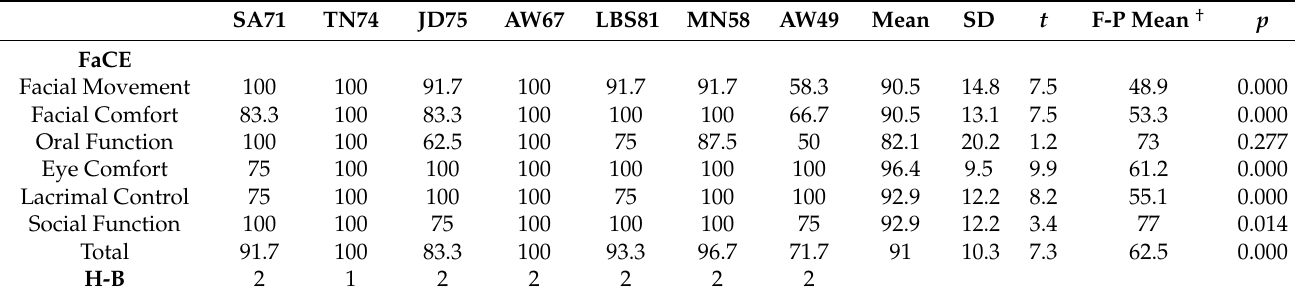
Table 1. FaCE (Facial Clinimetric Evaluation) and House–Brackmann Facial Nerve Grading Scale (H-B).